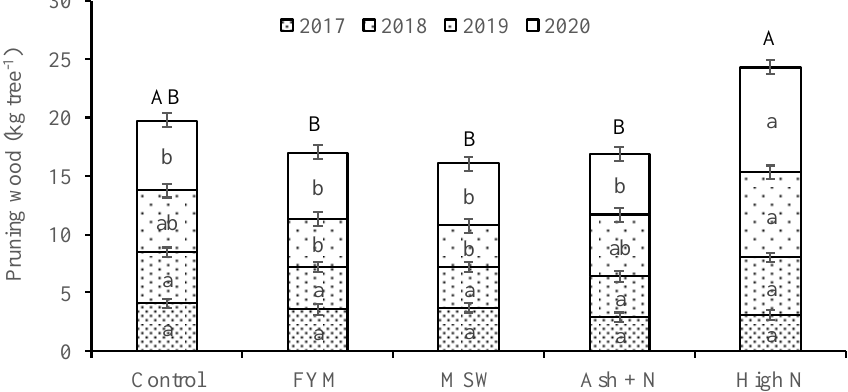
Figure 3. Pruning wood from four consecutive pruning events as a function of fertilizer treatments: control, compound NPK (50 kg ha − 1 of N, P 2 O 5 and K 2 O); FYM, farmyard manure (rate equivalent of 50 kg N ha − 1 ); MSW, municipal solid waste (rate equivalent of 50 kg N ha − 1 ); Ash + N, bottom ash (4 t dw ha − 1 ) plus 50 kg N ha − 1 ; and High N, high N rate (120 kg N ha − 1 and 50 kg ha − 1 P 2 O 5 and K 2 O). Within each year (lowercase) and total (uppercase), means followed by the same letter are not significantly different by Tukey HSD test (α = 0.005). Vertical bars are standard errors.